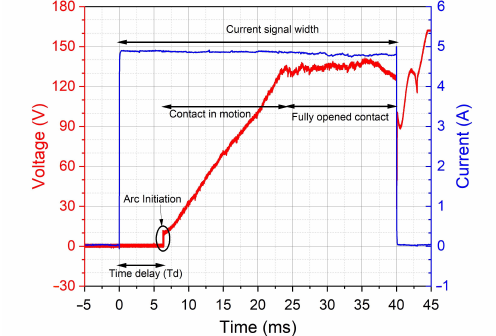
Figure 4. Typical Volt-Ampere characteristic at 4.87